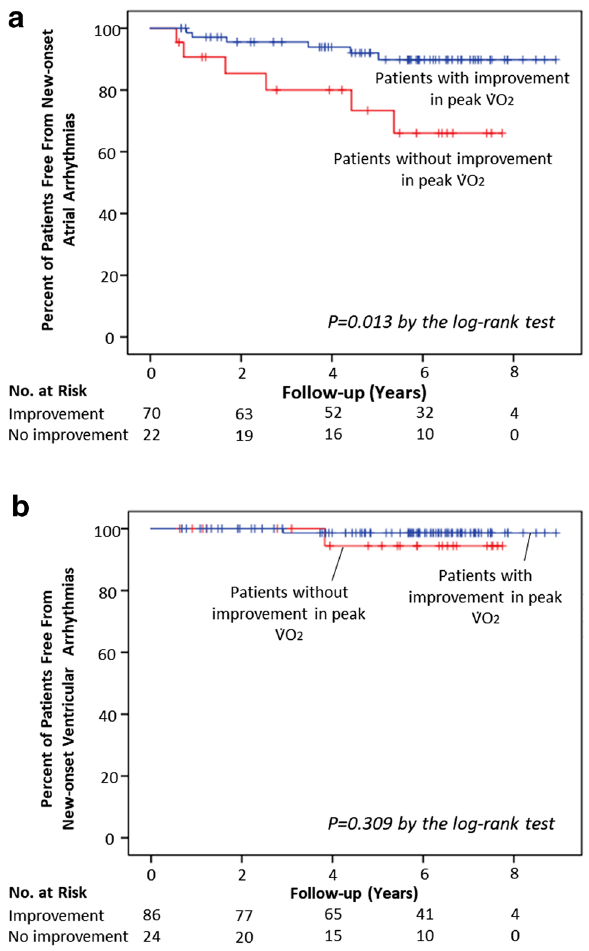
Figure 2. New-onset atrial ( a ) and ventricular ( b ) arrhythmias over time. The Kaplan–Meier estimates of the incidence of new-onset atrial and ventricular arrhythmias over a median follow-up of 6 years are shown for high-risk patients with improvement in peak V ̇ O 2 , high-risk patients without improvement in peak V ̇ O 2 , and patients with a preserved V ̇ O 2 . Tick marks indicate censored data. HF, heart failure; V ̇ O 2 , peak exercise oxygen consumption.